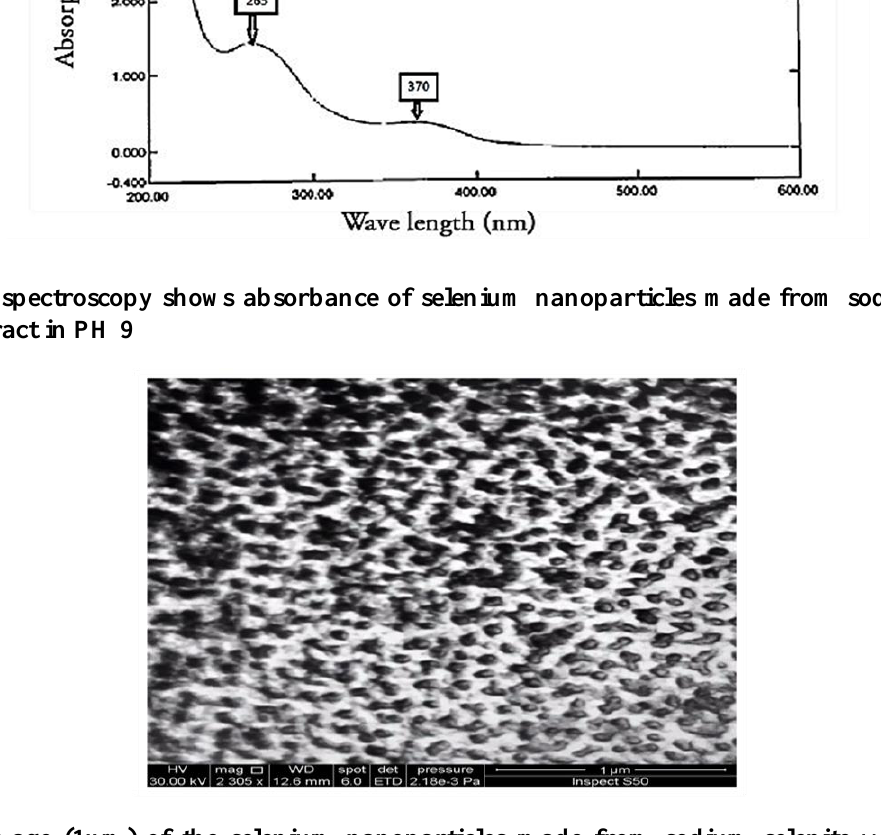
Figure 3. SEM image (1µm) of the selenium nanoparticles made from sodium selenite with black currant extract in percentage 1:2, v: v ratio in PH 9